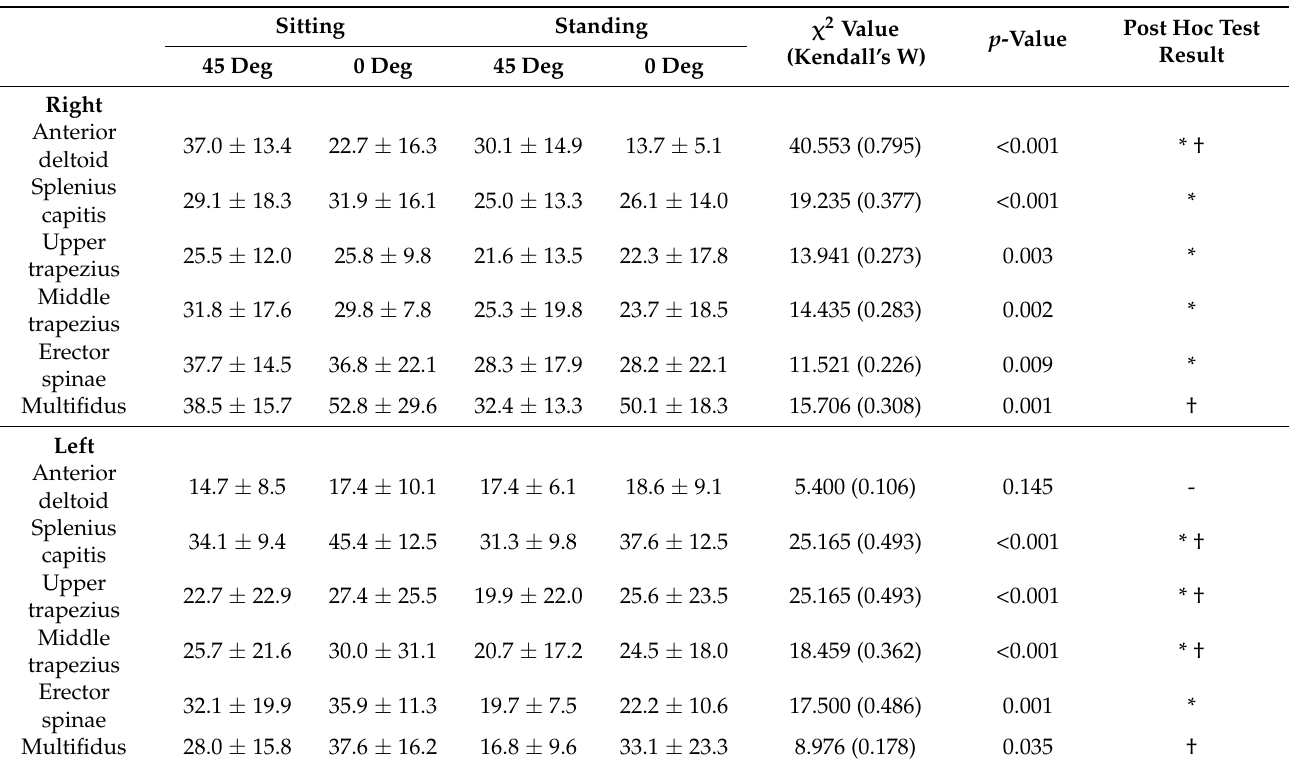
Table 3. Mean normalized muscle activities (% peak EMG activity) during the task in each experi- mental